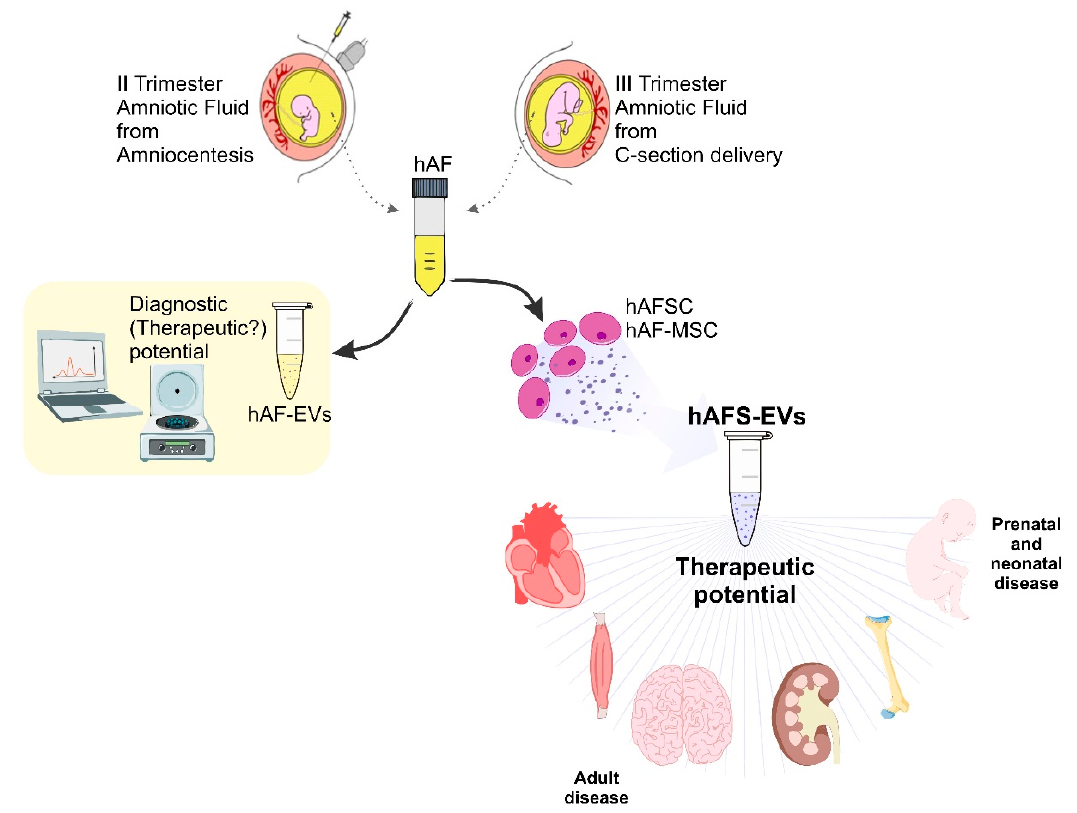
Figure 1. Schematic of the therapeutic and diagnostic potential of hAFSC-EVs and hAF-EVs for future paracrine therapy and personalised medicine. C-section: caesarean-section; hAF: human amniotic fluid; hAF-EVs: human amniotic fluid-derived extracellular vesicles; hAFSC: human amniotic fluid-derived stem cells; hAF-MSC: human amniotic fluid-derived mesenchymal stromal cells; hAFS-EVs: human amniotic fluid stem cell-extracellular vesicles. Schematic has been produced adapting images from Smart—Servier Medical Art (https://smart.servier.com; accessed on 14 December